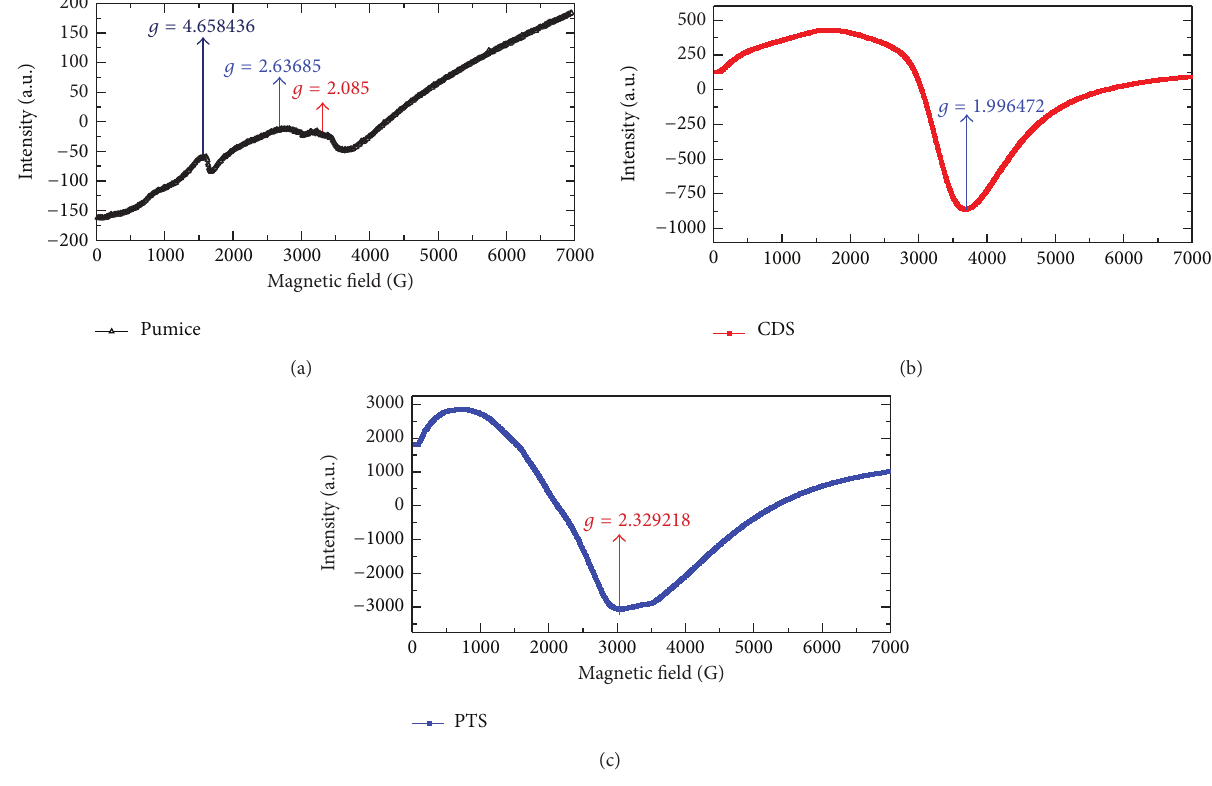
Figure 3: X-band EPR spectra of the volcanic rocks: (a) pumice, (b) CDS, and (c) PTS.